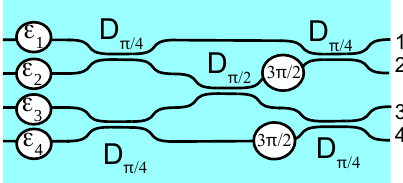
Figure 3. Sketch of an integrated quantum